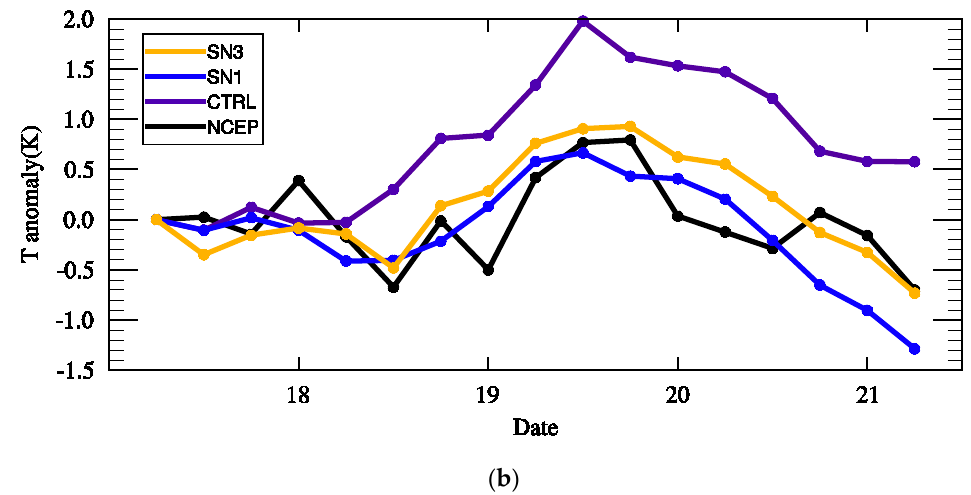
Figure 5. Temporal evolution of observed and simulated ( a ) minimum sea level pressure(units: hPa) and ( b ) mean temperature anomaly of the whole troposphere (units: K); where black, purple, blue, brown respectively correspond with observation (NCEP), CTRL, SN1, SN3.